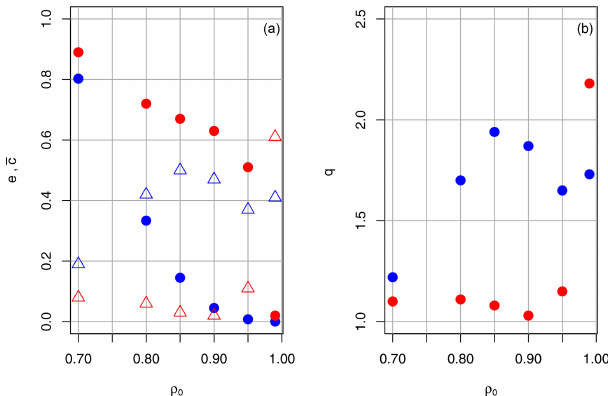
Figure 1. Drought in the GE region in the SHY, showing the (a) av- erage (period 1951–2019) edge density e (blue dots) and global clustering coefficient c (red dots) as a function of the correlation threshold ρ 0 for the SHY in Germany. Also shown is the ratio of standard deviation to the average for e (blue open triangles) and c (red open triangles) as a function of the correlation threshold. (b) The same applies for the ratio q of extreme to normal years, calculated with e (blue) and c